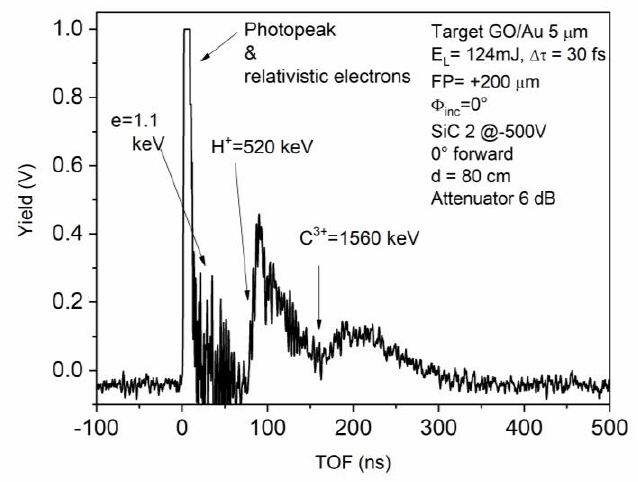
Figure 9. SiC-TOF obtained by irradiating a GO/Au thin foil in the TNSA regime at Celia Labora-